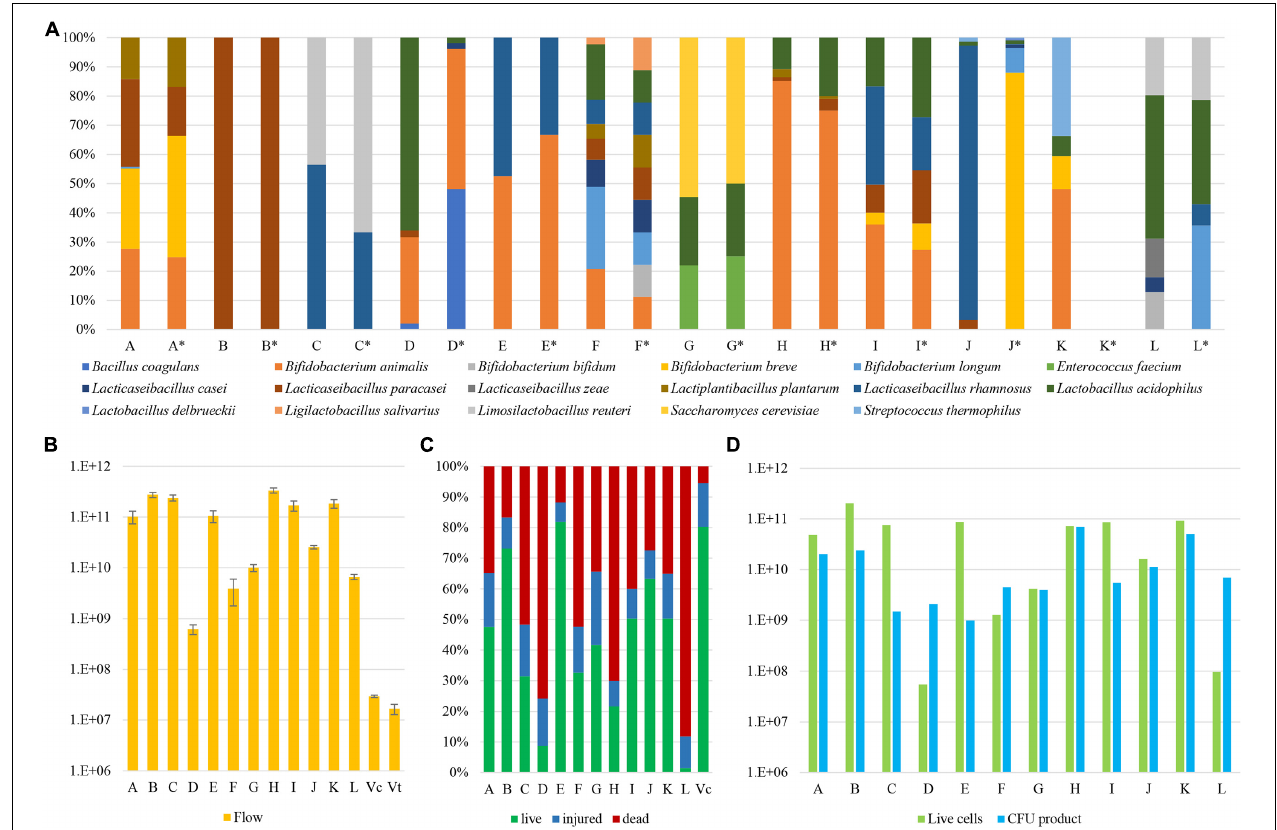
FIGURE 2 | Microbial composition, quantification, and viability of probiotic supplements. Panel (A) displays the relative abundance of each microbial species identified in the analyzed probiotic samples. Each probiotic supplement is reported with an identification letter from A to L, which declared composition is listed in detail in Table 1 and reported in pillars marked with an asterisk. Panel (B) shows the quantification of the absolute number of microbial cells within each probiotic product. Pillars Vc and Vt report the cell enumeration data of a control sample by means of a flow cytometry assay and a counting chamber, respectively. Panel (C) depicts the percentage of viable, injured, and dead cells among individual samples. Finally, panel (D) exhibits the normalized number of viable cells (green) next to the value as stated by the producers